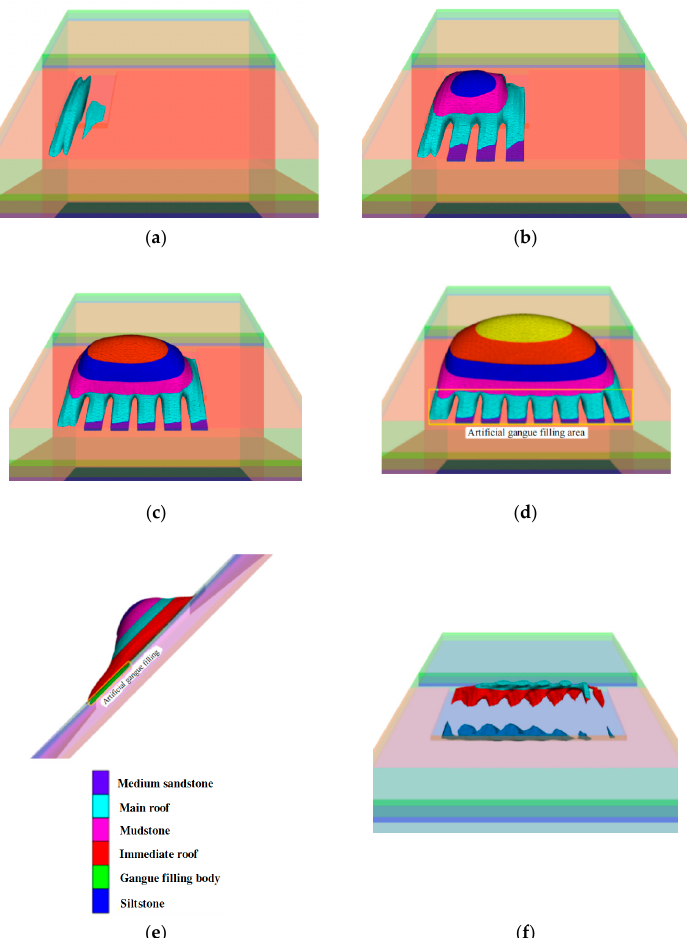
Figure 6. Overburden collapse form of local filling mining. Different colors represent different lay- ers. ( a ) 40 m; ( b ) 80 m; ( c ) 120 m; ( d ) 160 m; ( e ) Inclined overburden collapse form; ( f ) Overburden stress release